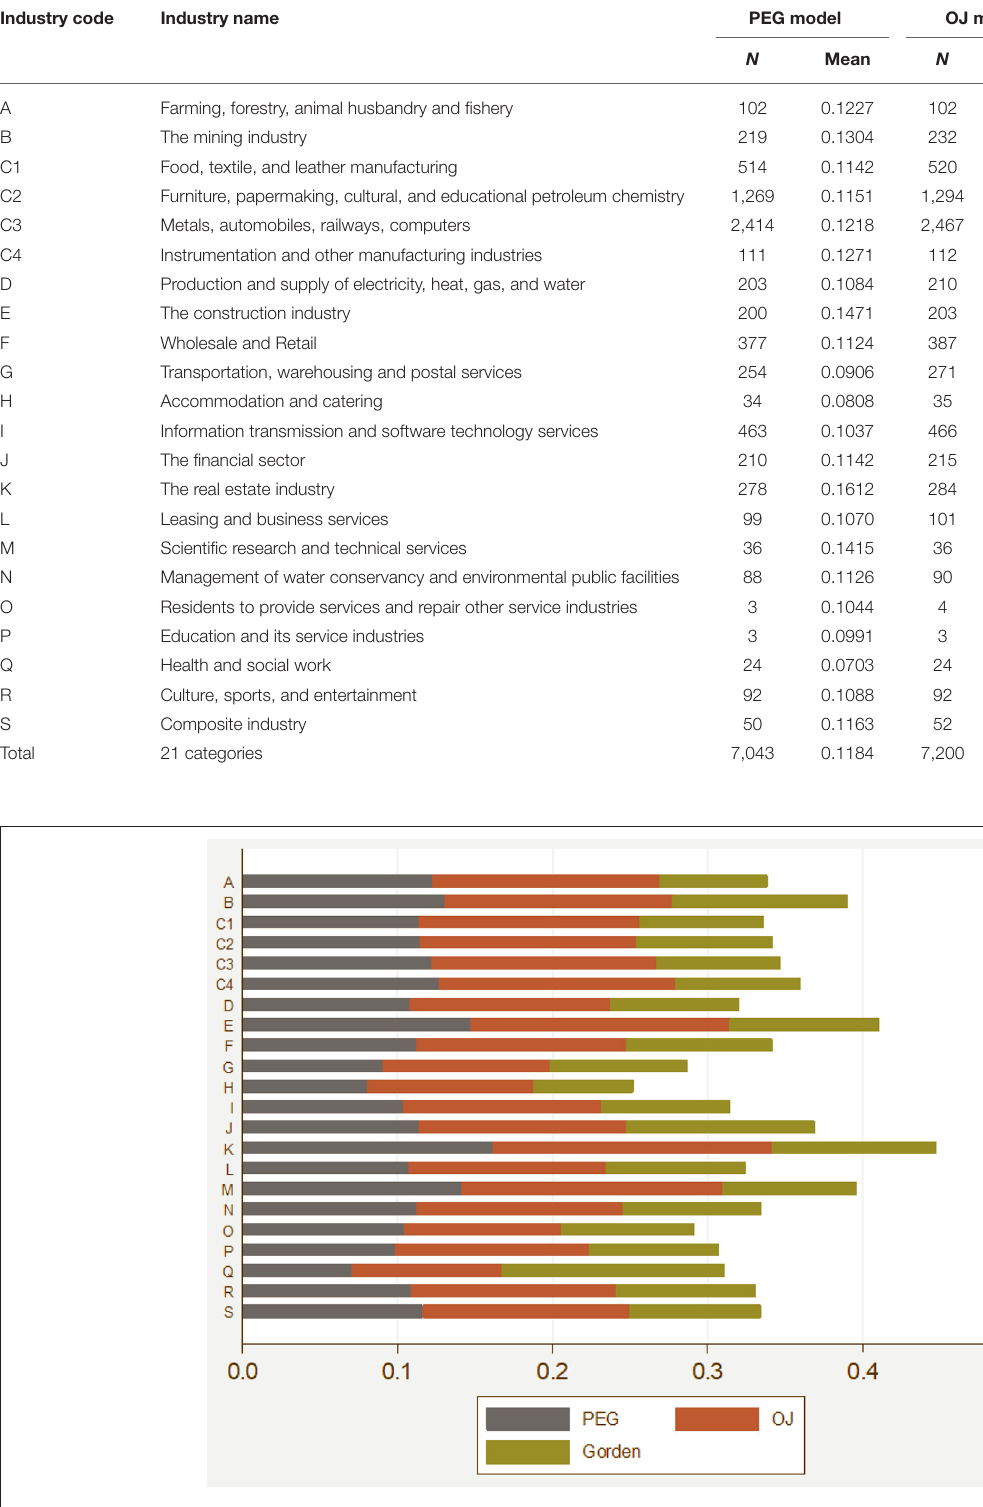
FIGURE 2 | The mean value of equity cost by industry from 2005 to